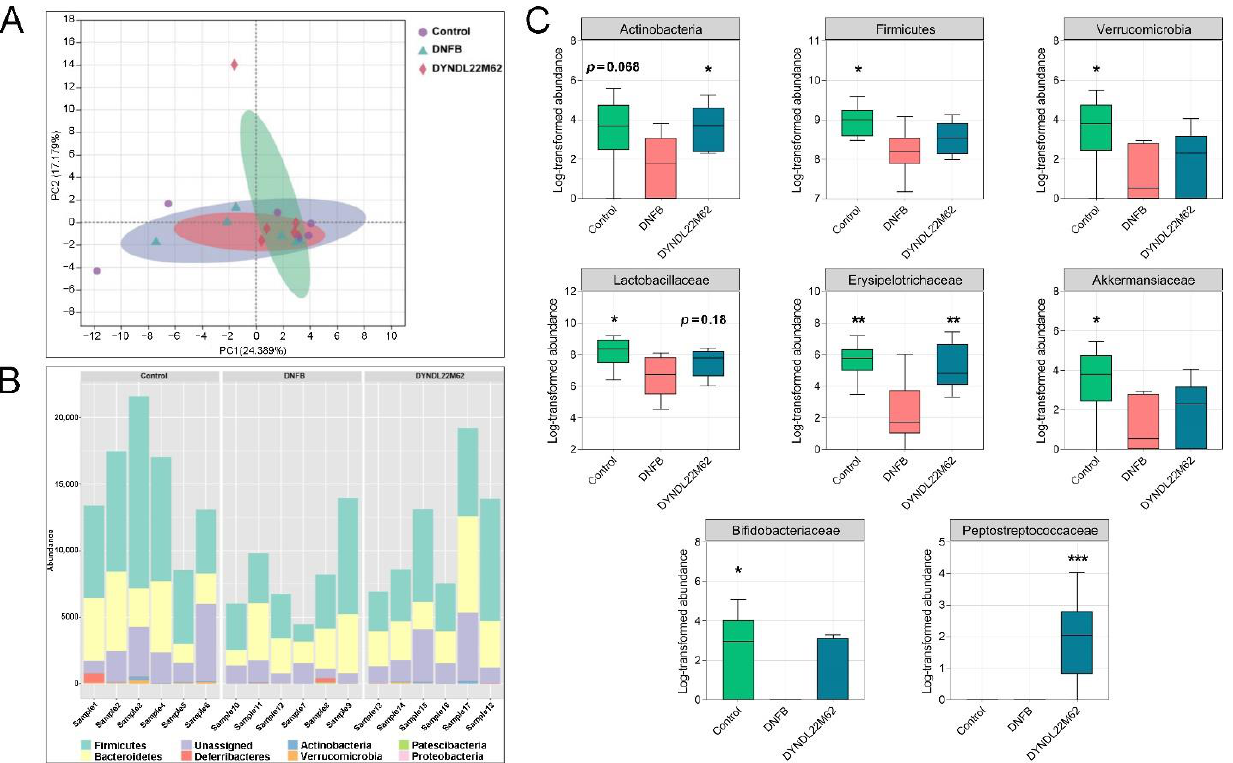
Figure 4. L. reuteri strains regulated gut microbiota in AD-like mice. ( A ) PCA plot between groups. ( B ) Gut microbial composition at the phylum level. ( C ) Effects of L. reuteri DYNDL22M62 on gut microbial composition. * p < 0.05, ** p < 0.01, *** p < 0.001 vs DNFB group. PCA, principal component analysis, PC1, principal component 1, PC2, principal component 2.